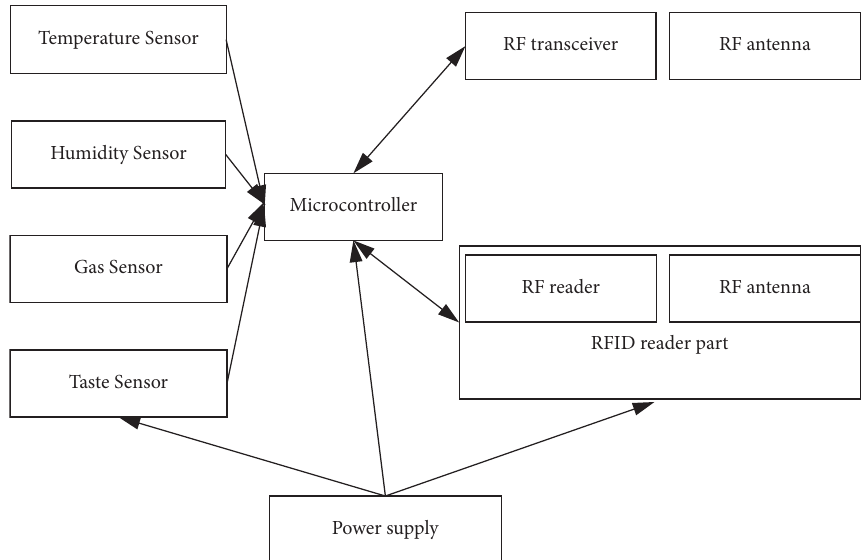
Figure 4: Structural drawing of the smart